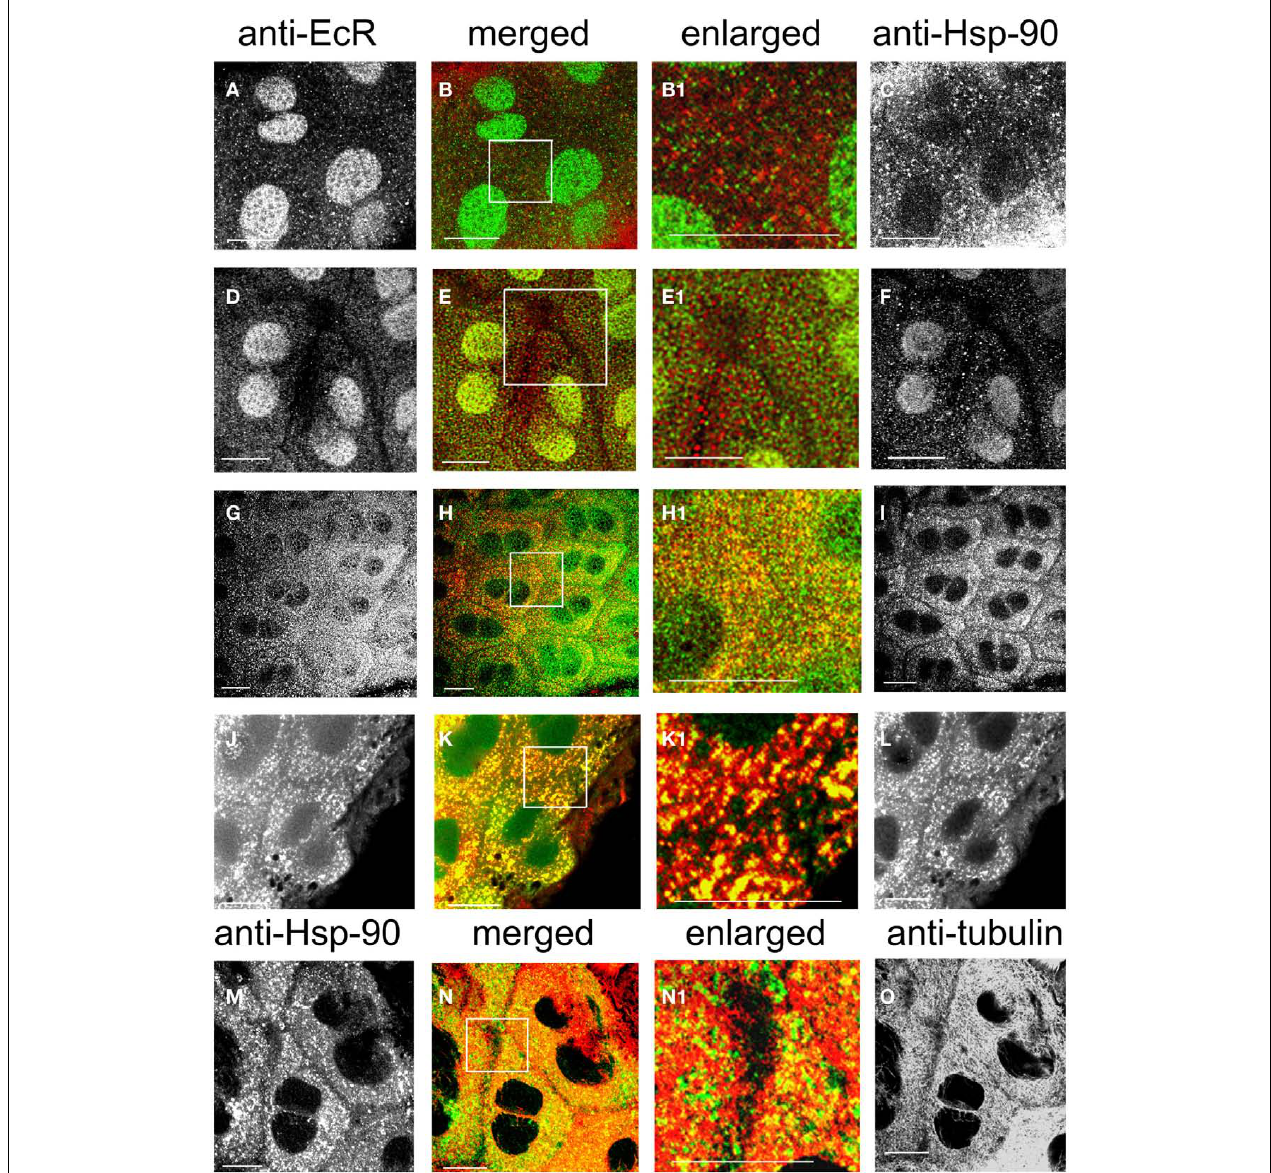
co-localization of Hsp90 fluorescence with anti-tubulin (N1) . (A–F) Show SG cells in scotophase and (G–I) shows cells in photophase. Note absence of co-localization in the cytoplasm in scotophase [abundance of red and green specks in (B1,E1) ] and widespread co-localization in photophase [abundance of yellow/orange specks in (H1) ]. (J–L) Shows cells pre-treated with taxol. Note the arrangement of co-localized EcR and Hsp90 fluorescence in yellow lines (K1) . In (N1) , note co-localization of Hsp90 fluorescence with tubulin fluorescence (yellow specks along MTs). Scale bars = 10 μ m.